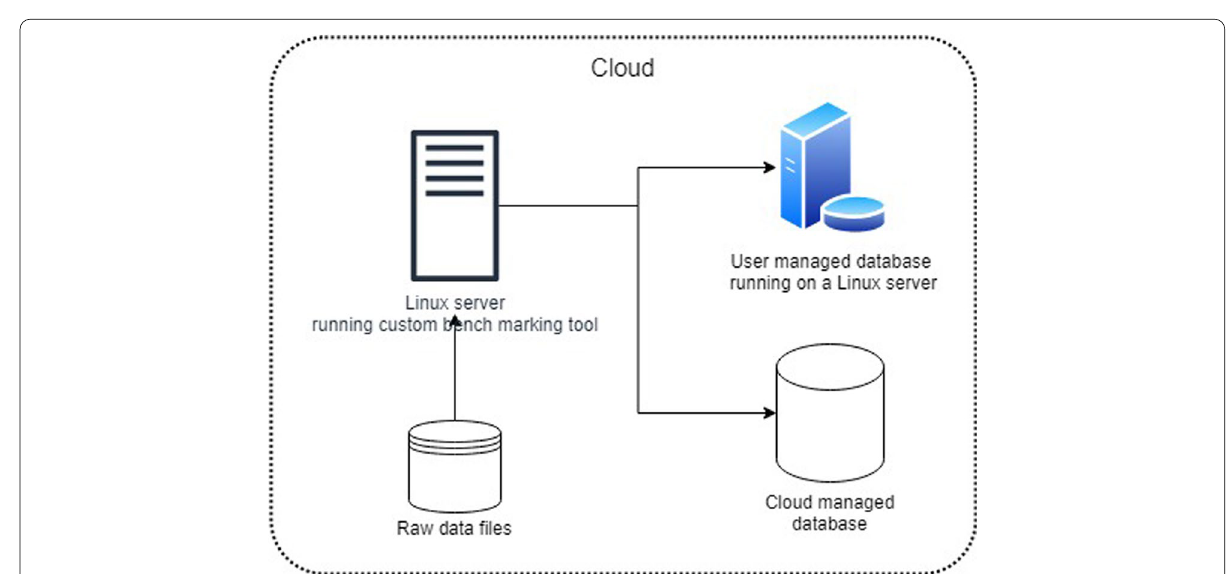
Fig. 3 Architecture used to conduct our